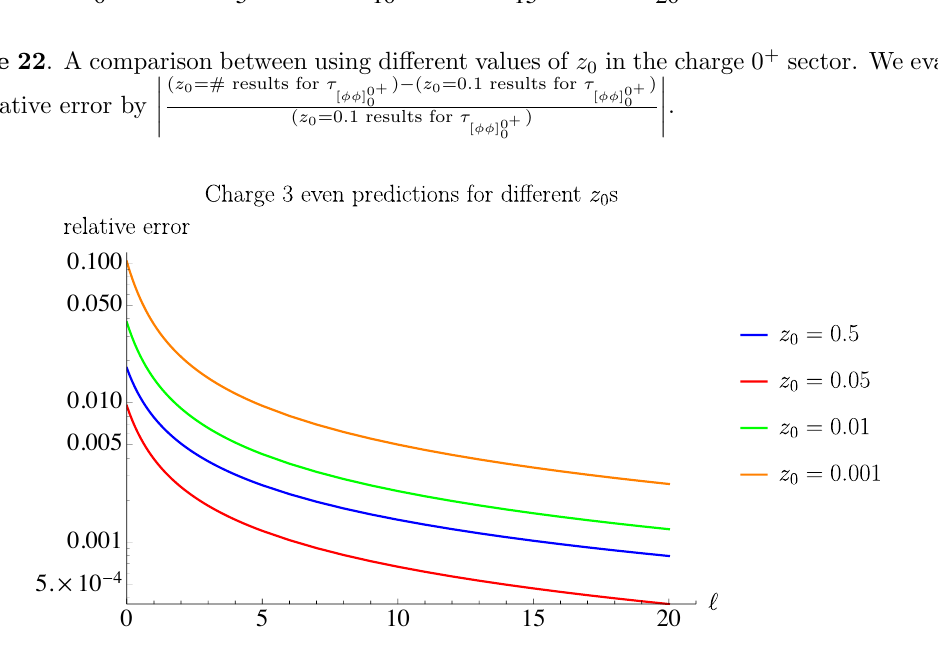
Figure 23 . A comparison between using di(cid:11)erent values of z 0 in the charge 3 even-spin sector. We evaluate the relative error